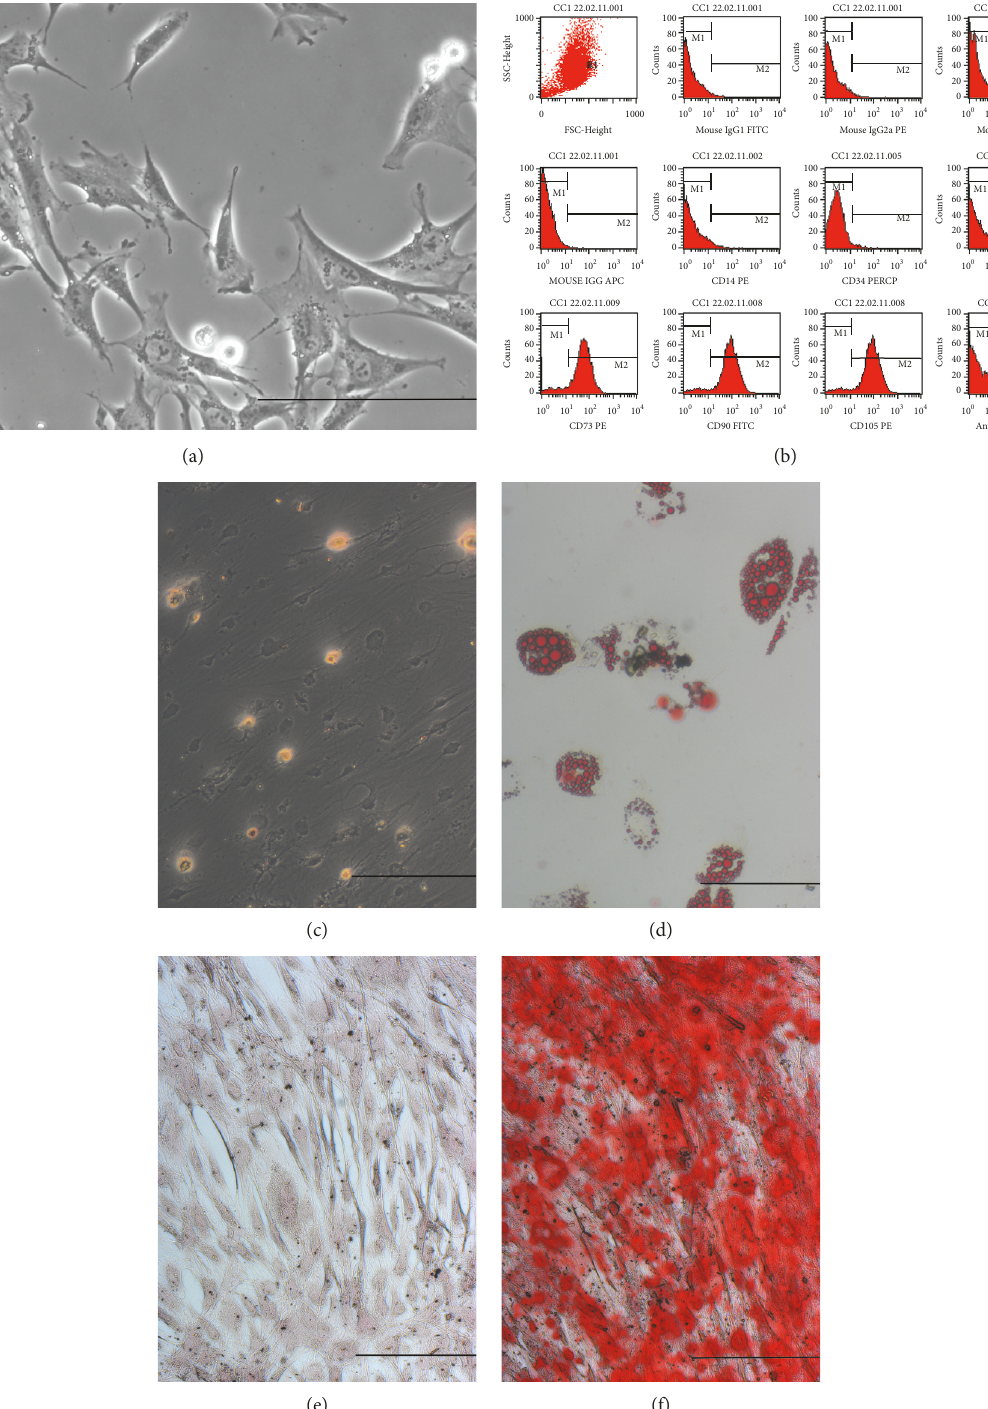
Figure 4: Analysis of the mesenchymal stem cell compartment. (a) Characteristic fi broblastoid morphology of MSC. (b) Immunophenotyping of MSC cultures showing negative results for CD34, CD14, CD45, and HLA-DR, and positive results for CD73, CD90, and CD105. (c), (d) Oil Red O staining of control and adipocyte-di ff erentiated cultures, respectively. (e), (f) Alizarin red staining of control and osteoblast-di ff erentiated cultures, respectively. Original magni fi cation: × 400 (a), × 200 (c) – (f). Scale bar: 100 μ